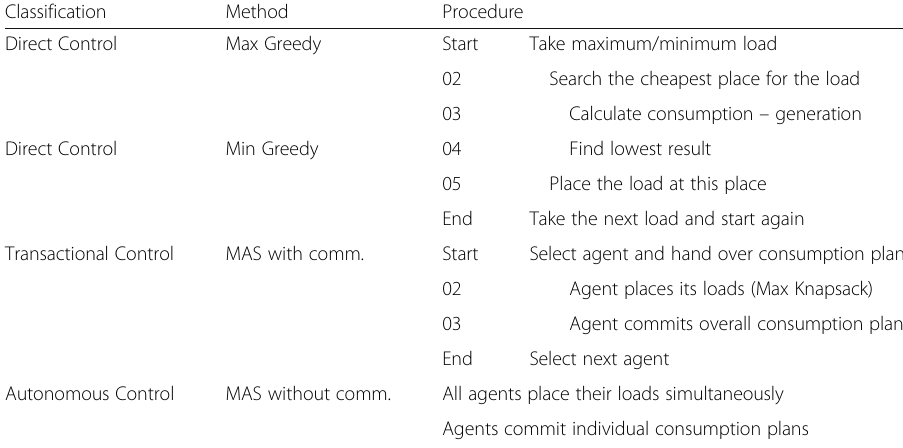
Table 5 Description of the chosen methods Classification Method Procedure Direct Control Max Greedy Start Take maximum/minimum load 02 Search the cheapest place for the load 03 Calculate consumption – generation Direct Control Min Greedy 04 Find lowest result 05 Place the load at this place End Take the next load and start again Transactional Control MAS with comm. Start Select agent and hand over consumption plan 02 Agent places its loads (Max Knapsack) 03 Agent commits overall consumption plan End Select next agent Autonomous Control MAS without comm. All agents place their loads simultaneously Agents commit individual consumption